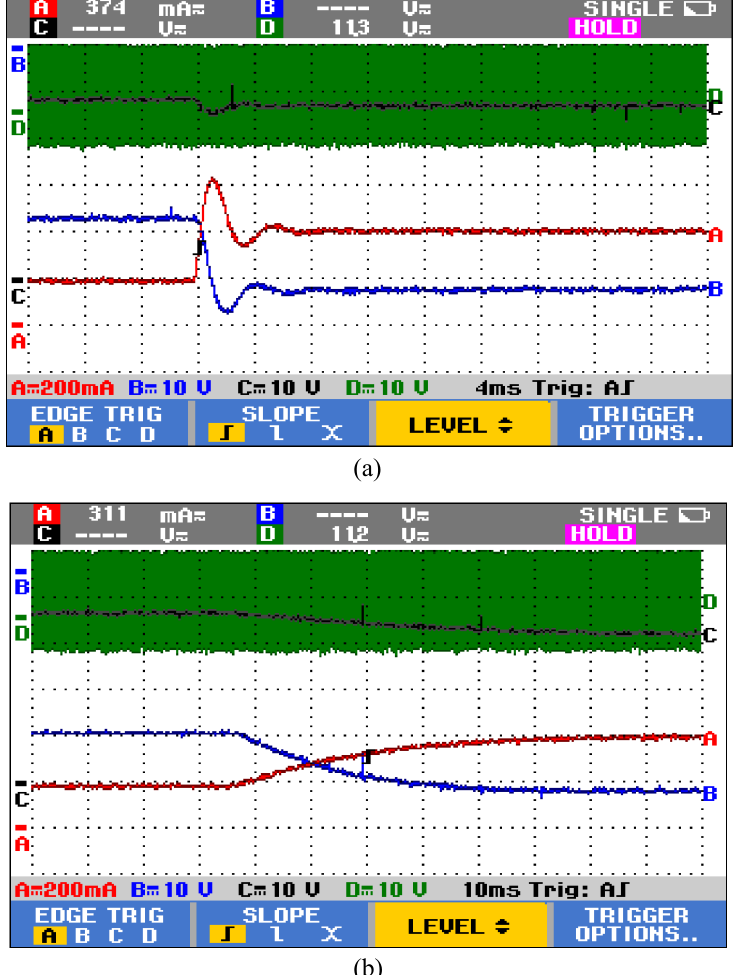
Figure 11. Experimentally measured response of the converter with PV source: ( a ) open-loop system and ( b ) closed-loop system, to a step change in control variable, showing Ch A: source current with 1 V/5 A sensor gain and 200 mV/div, Ch B: converter output voltage 10 V/div, Ch C: source voltage 10 V/div, Ch D: gate pulses given to IGBT 10